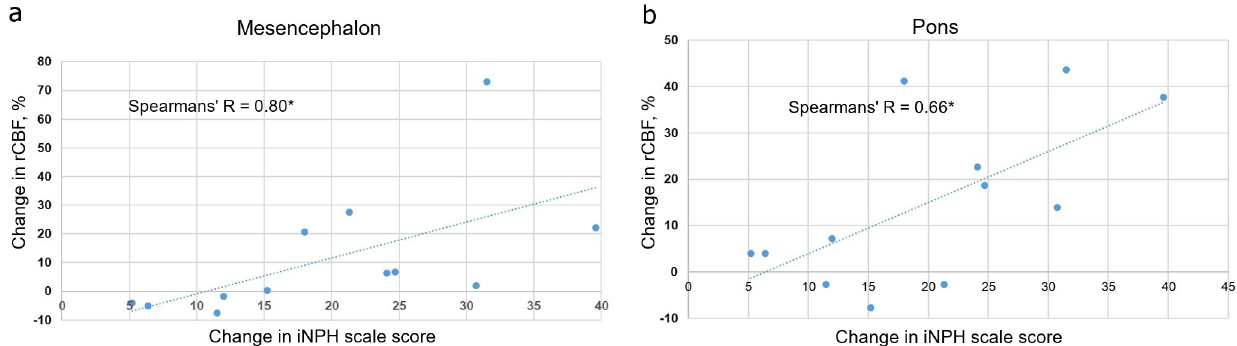
Fig 3. Correlations between rCBF and iNPH scale score. Correlations between change in relative cerebral blood flow (rCBF) in the mesencephalon (a) and pons (b) and change in the iNPH scale score after surgery in responders.